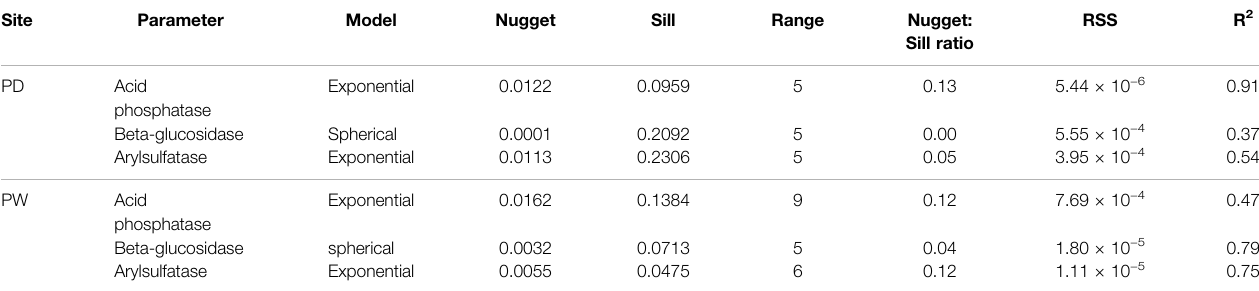
TABLE 8 | Spatial dependence of soil enzyme activity in the surface and subsurface horizons of the rewetted and drained peatlands.